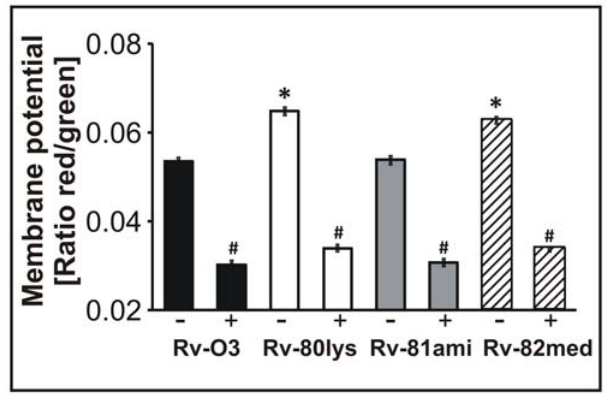
Figure 4. Determination of the membrane potential of Mtb strains. The relative membrane potential was calculated using the average mean fluorescence intensity (the ratio between the average red fluorescence and the average green fluorescence). The graph shows the average of four experiments. Wild type and lysX mutant strains were incubated with 3 m M DiOC 2 (3) for 5 h in either the presence ( + ) or absence ( 2 ) of 100 m M CCCP. The bars represent the mean 6 standard error. * Represents P , 0.002 versus Rv-03 and Rv-81ami (Student- Newman-Keuls Method), whereas # refers to P =0.001 compared to untreated with